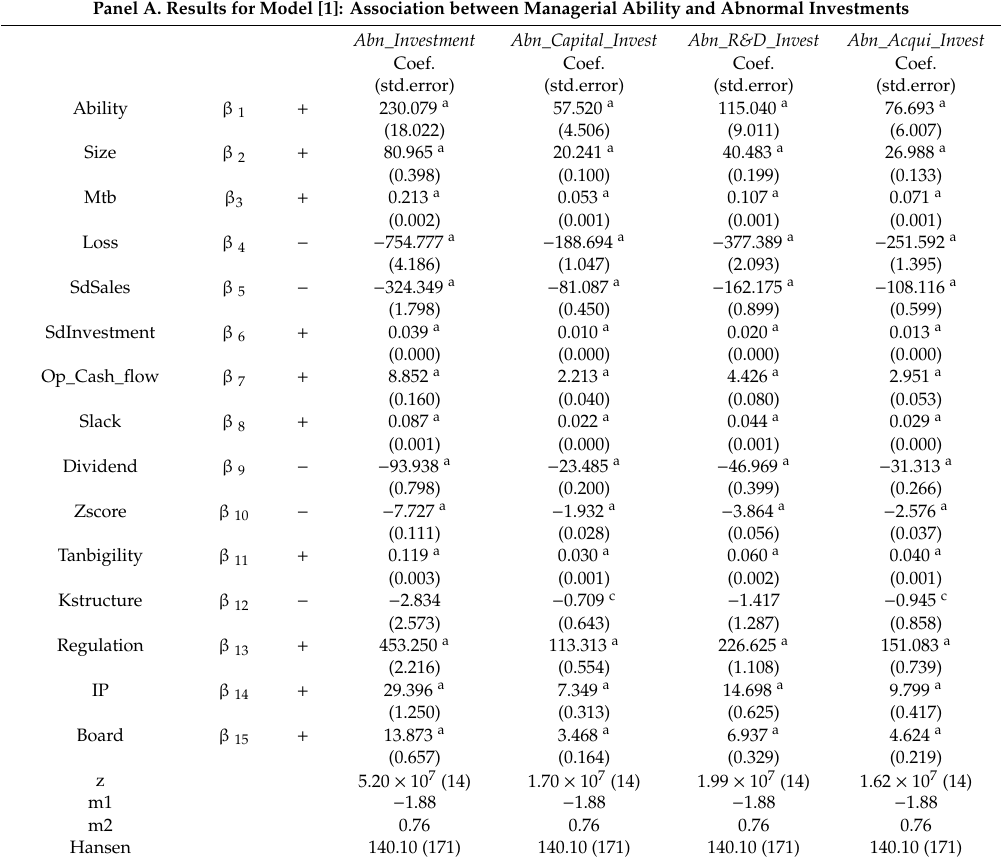
Table 6. Robust results for managerial ability and abnormal investments. Panel A. Results for Model [1]: Association between Managerial Ability and Abnormal